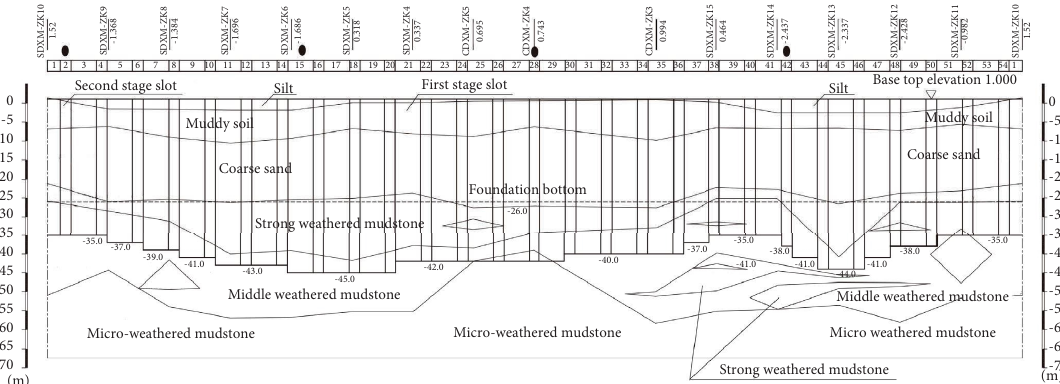
Figure 2: Slot expansion